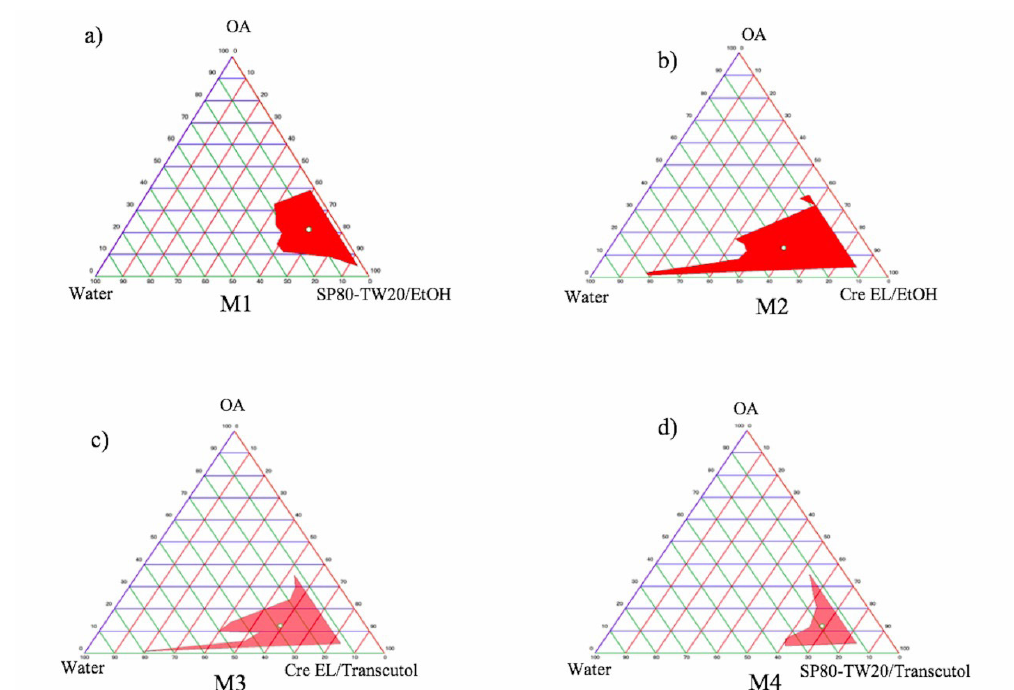
FIGURE 1 - The pseudo-ternary phase diagrams of the microemulsion. (a) The pseudo-ternary phase diagram of the microemulsion composed of OA, SP80, TW20, ethanol and water (w/w). (b) The pseudo-ternary phase diagram of the microemulsion composed of OA, Cre EL, EtOH and water (w/w). (c) The pseudo-ternary phase diagram of the microemulsion composed of OA, Cre EL, Transcutol HP and water (w/w). (d) The pseudo-ternary phase diagram of the microemulsion composed of OA, SP80, TW20, Transcutol HP and water